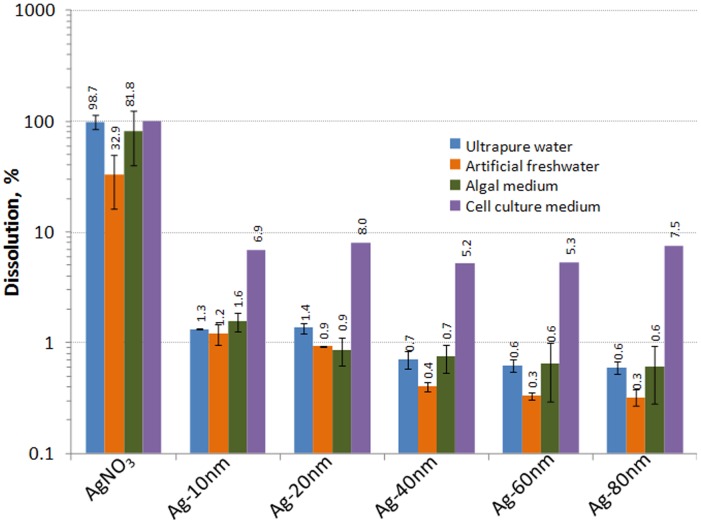
Dissolution (%) of Ag NPs in different test media.Ultrapure water was used as a solvent to mimic the dissolution in the bacterial and yeast assays, OECD 202 artificial freshwater was used for Daphnia magna assay, algal test medium for Pseudokirchneriella subcapitata and cell culture medium for Balb/3T3 murine fibroblast assay. Dissolved ionic Ag was measured after incubation of 1 mg/L Ag NPs or 0.01 mg/L AgNO3 for 4 hours (ultrapure water), 24 hours (cell culture medium), 48 hours (artificial freshwater) or 72 hours (algal medium), depending on the length of the toxicity assay. The results shown were measured from Ag NPs suspensions and AgNO3 solution after ultracentrifugation. These results were confirmed by single particle (SP)-ICP-MS according to which 1.4% of 10 nm Ag NPs, 1% of 20 nm Ag NPs and 0.5% of 10 nm Ag NPs had been dissolved in ultrapure water.